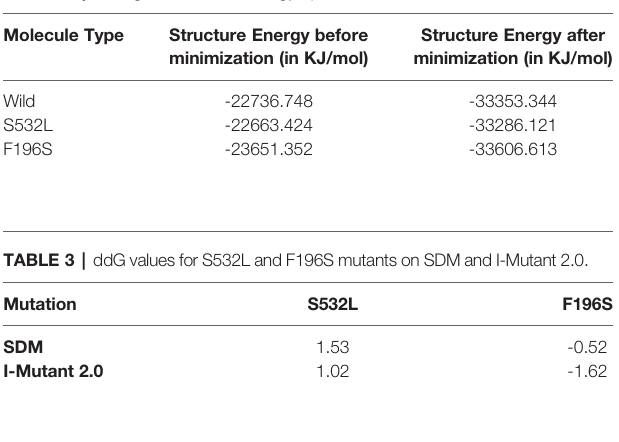
TABLE 2 | Change in structure energy upon minimization.